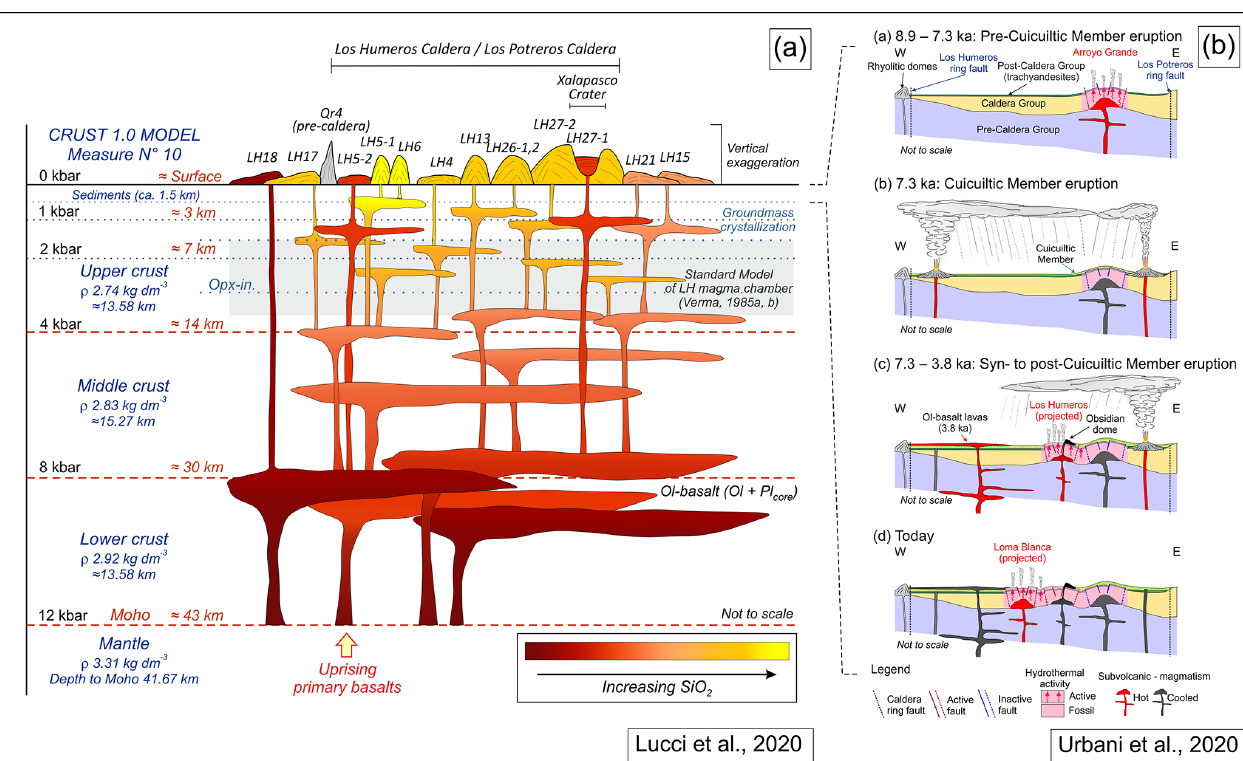
Figure 7. (a) Schematic representation (not to scale) by Lucci et al. (2020), of the magmatic plumbing system feeding the Los Humeros post-caldera stage activity, beneath the Los Humeros Caldera, as derived by pressure–temperature estimates obtained from mineral–liquid thermobarometry models. The model is integrated with the crustal structure (see Lucci et al., 2020, for further explanations). (b) Schematic model, by Urbani et al. (2020), of the evolution and of the subsurface structure of the Los Potreros caldera floor. Multiple magmatic intrusions located at a relatively shallow depth ( < 1km) are responsible for the localized bulging of the caldera floor (Arroyo Grande, Los Humeros and Loma Blanca uplifted areas). The Cuicuiltic Member eruption is assumed as a time marker in the evolution of the intracaldera